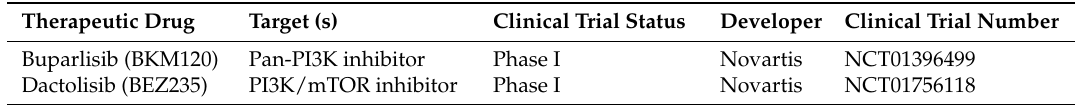
Table 3. PI3K inhibitors in clinical trial in